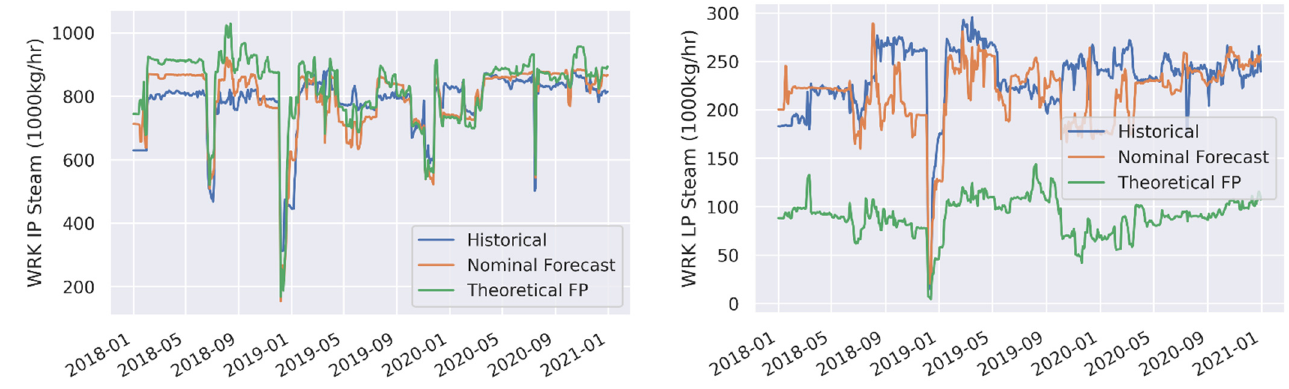
Figure 4. Intermediate pressure ( left ) and low pressure ( right ) separated steam flow to the Wairakei power station, comparing historically measured data versus the nominal forecast model (including the neural network flash plant model) and the theoretical flash plant forecast (using steam quality at separation pressure as separation efficiency).